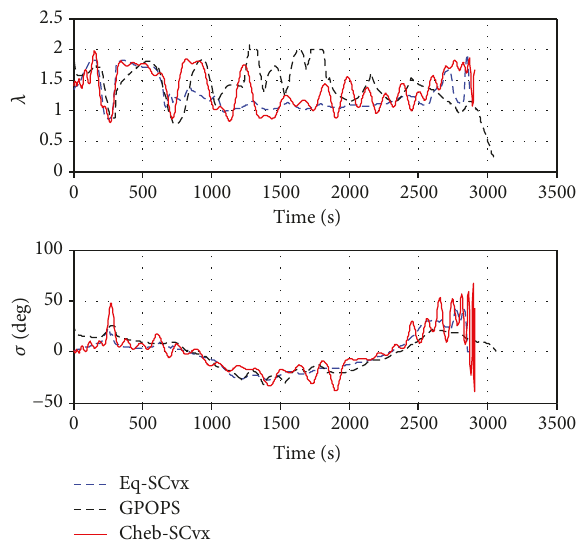
Figure 3: Altitude and velocity pro fi le.